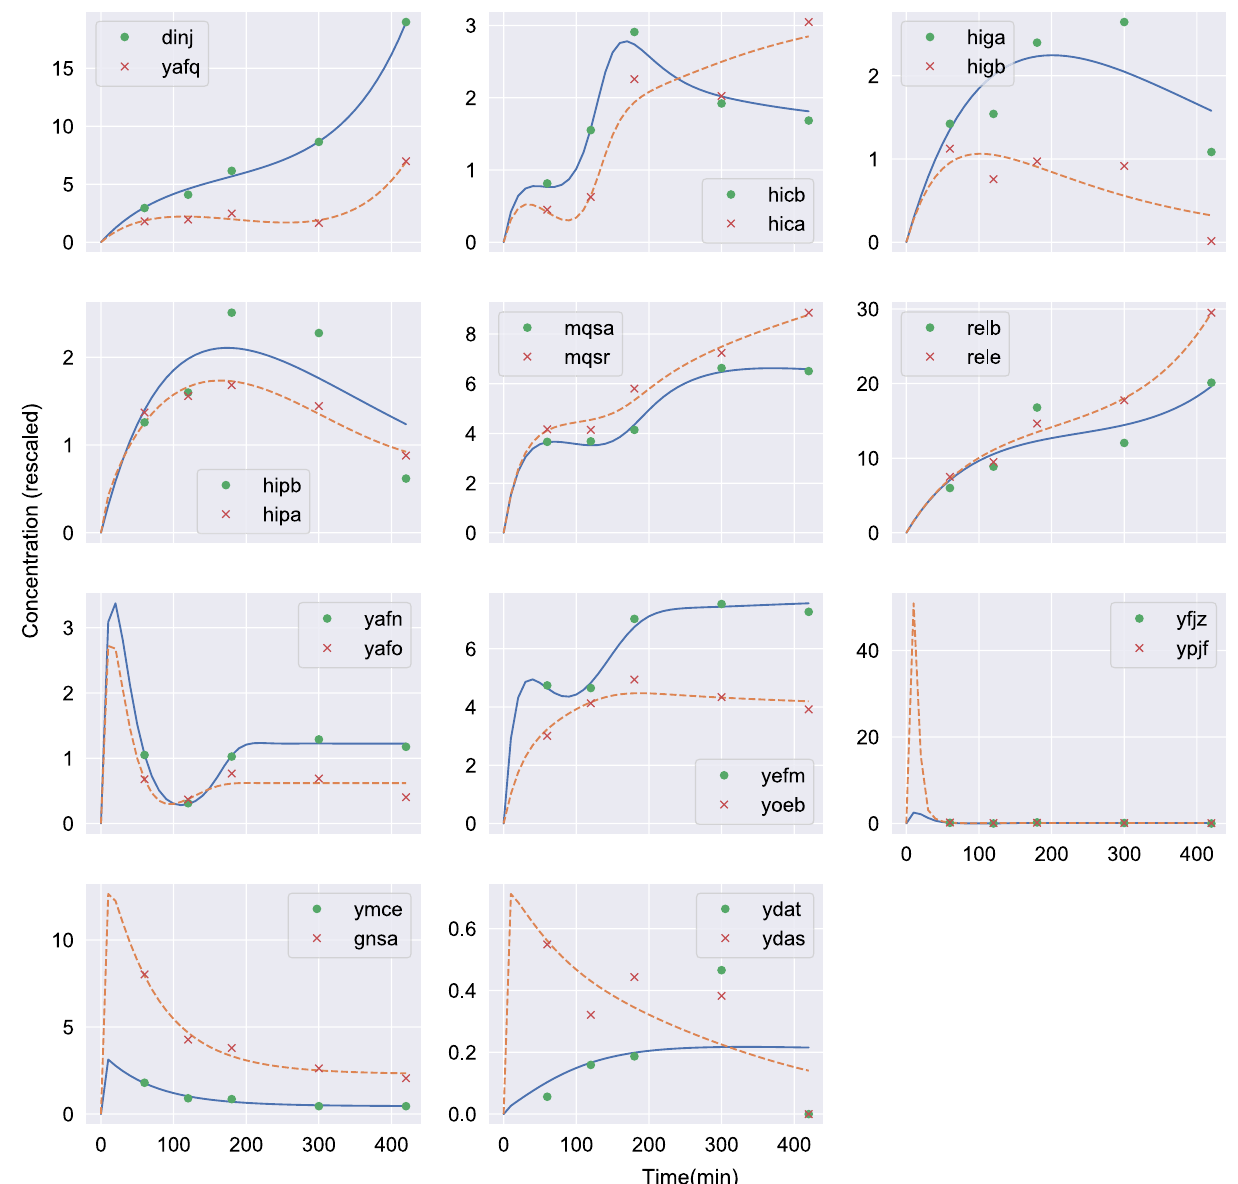
Figure 3. Toxin and antitoxin concentrations as a function of time for 11 known TA pairs of E. coli . Points represent RNA-Seq data for antitoxin (circles) and toxin (x-symbols) obtained from 41 . Solid lines show the result ( z 1 ( t ) ) of the numerical solution of the ODE system, Eqs. (4)–(6) for the antitoxin. Dashed lines show the corresponding variable ( z 2 ( t ) ) for the